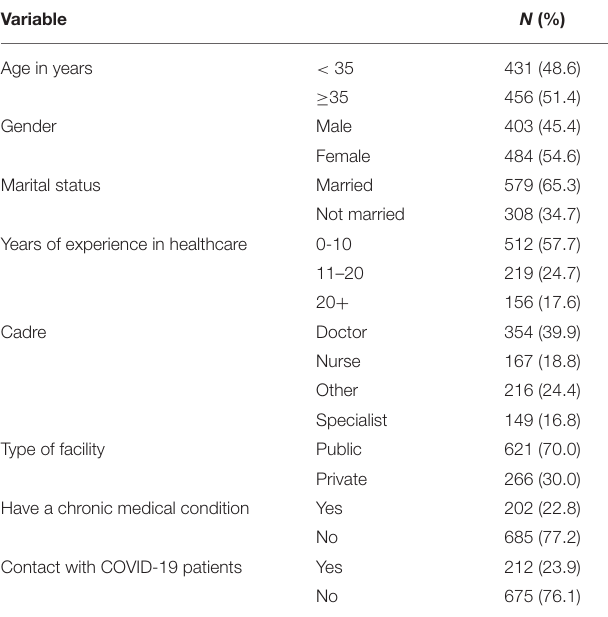
TABLE 1 | Socio-demographic characteristics of the